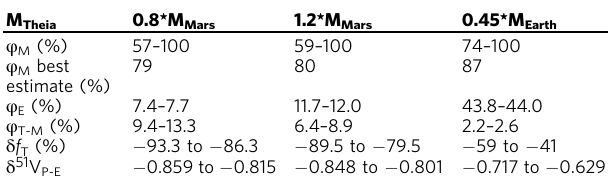
Table 1 Outputs of mixing calculations for different sizes of the impactor.